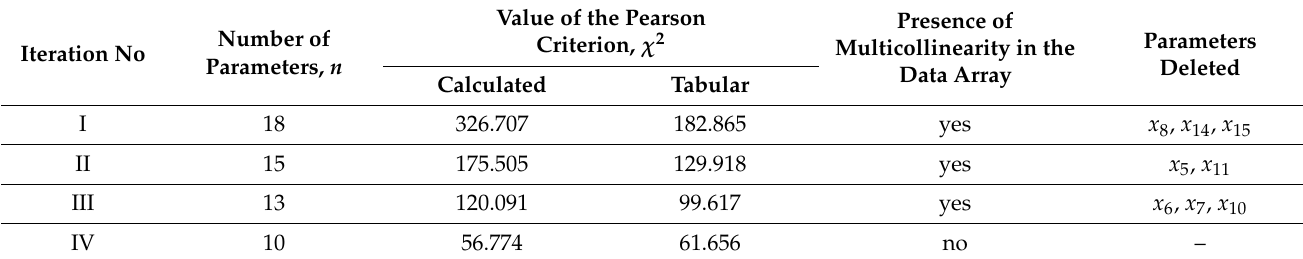
Table 6. The results of the step-by-step execution of the Farrar-Glober